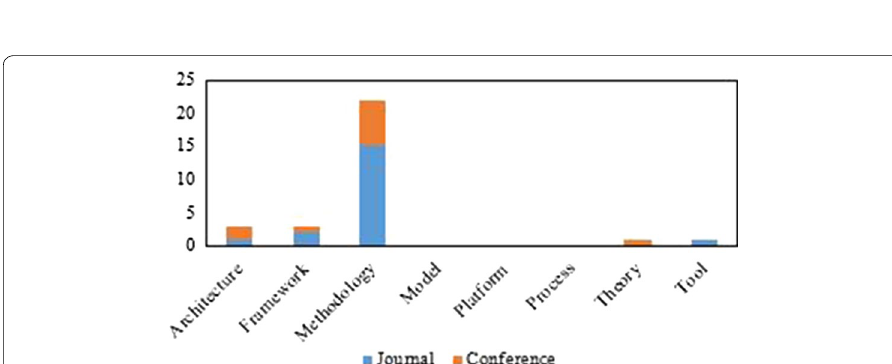
Fig. 6 Distribution of research contributions in journals and conferences. The figure shows the distribution of